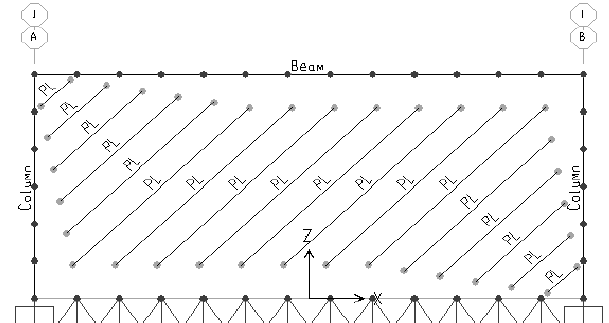
Fig. 2. Analyzed model of laboratory sample of Sabouri-Ghomi in software.